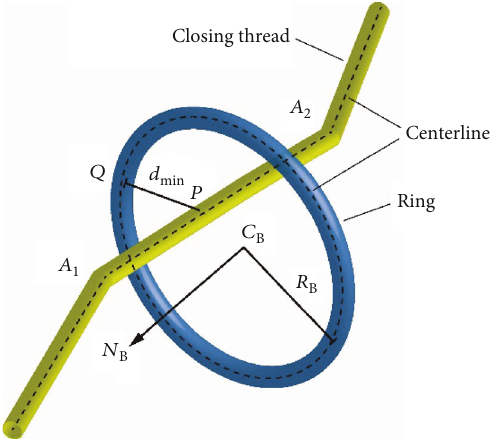
Figure 5: Discretized closing thread and